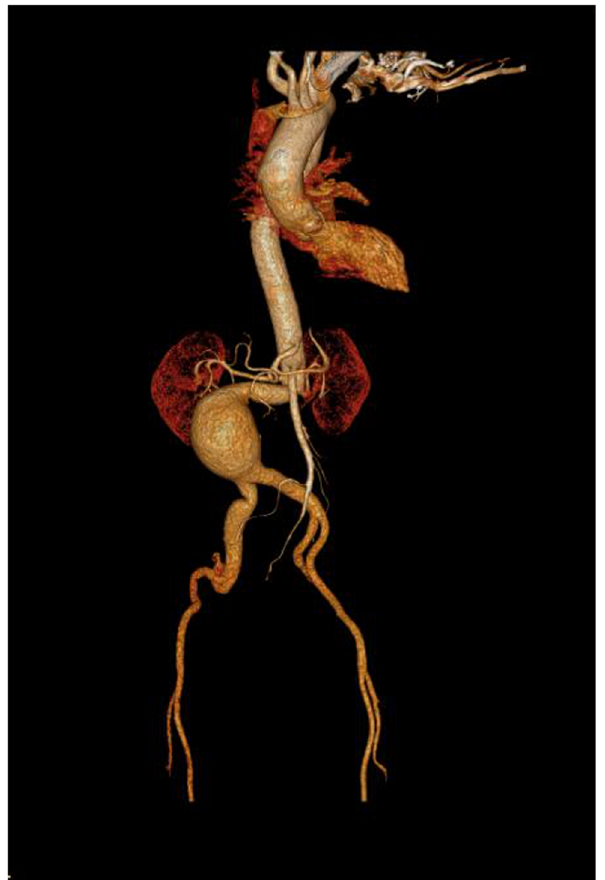
Figure 1. Computed tomography showing an infrarenal AAA with a sharp angled neck and a short neck. The right common iliac artery was severely